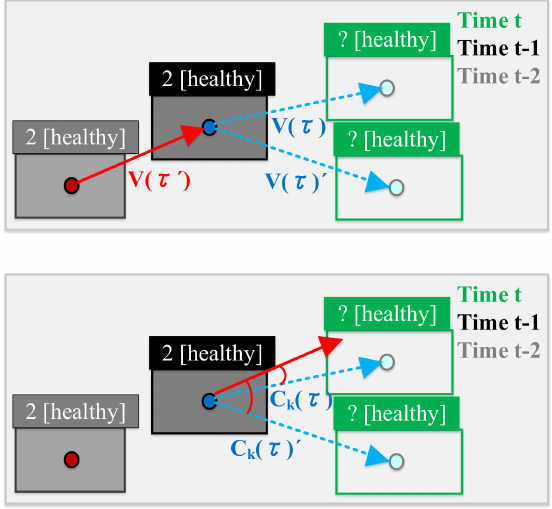
Figure 11. Illustration of V ( τ (cid:48) ) and V ( τ )